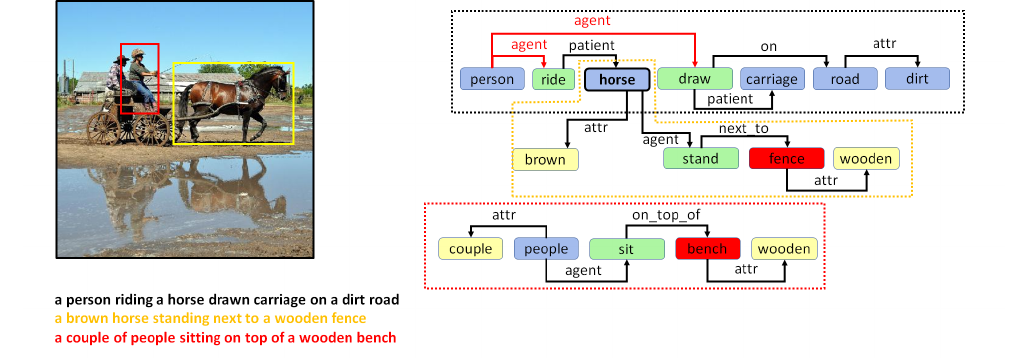
Figure 18. Holistic scene graphs demonstrating statistical bias forcing erroneous